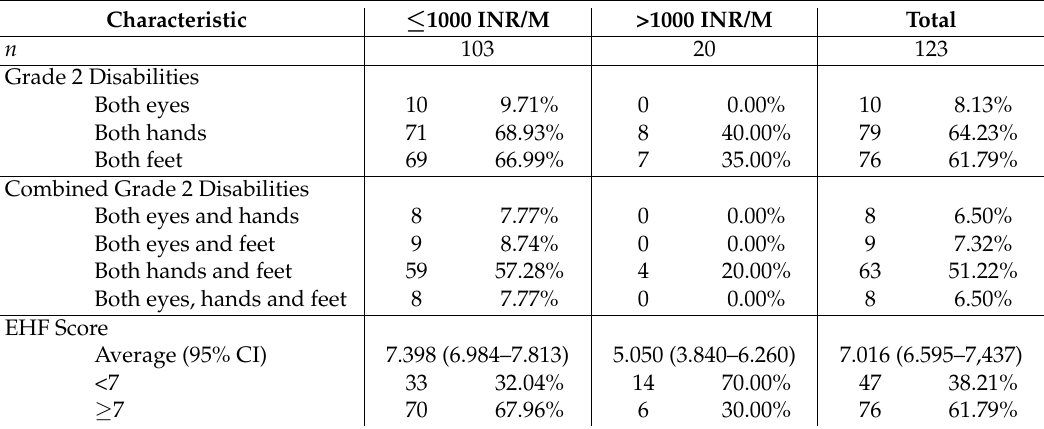
Table 3. Detailed disability grading of leprosy-affected study